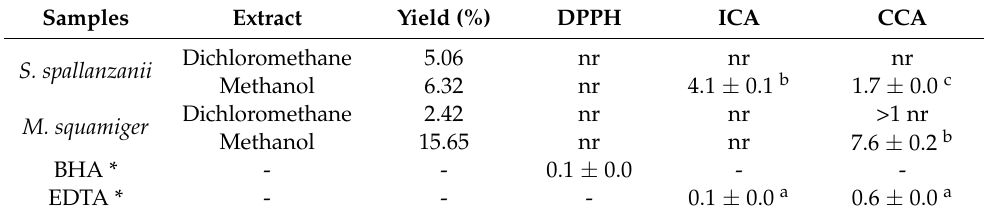
Data represents the mean ± standard error of mean (SEM) ( n = 6). In the same column, values followed by different letters are significantly different at p < 0.05 (one-way ANOVA with Tukey post hoc test); nr: IC 50 value not reached; * positive control; BHA: butylated hydroxyanisole; EDTA: ethylenediaminetetraacetic acid.